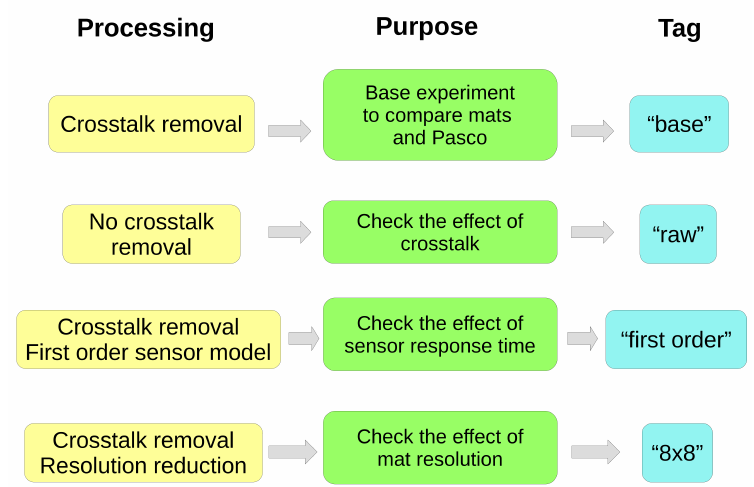
Figure 4. Schematic view of processing performed with